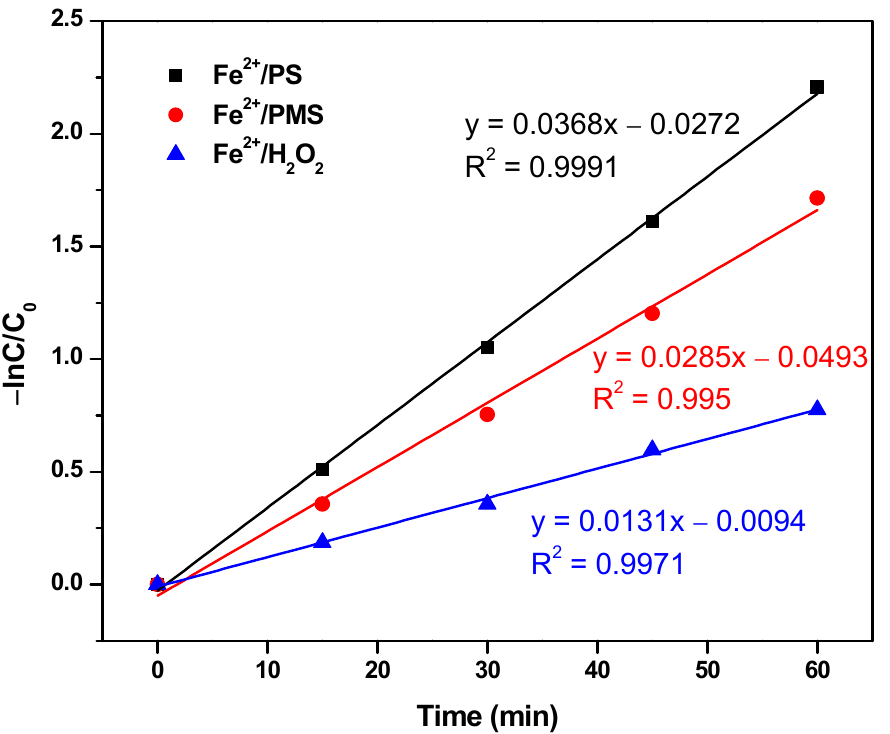
Figure 4. Pseudo-first-order kinetics for degradation of DCF sodium by H 2 O 2 /Fe 2+ , PS/Fe 2+. and PMS/Fe 2+ reactions.